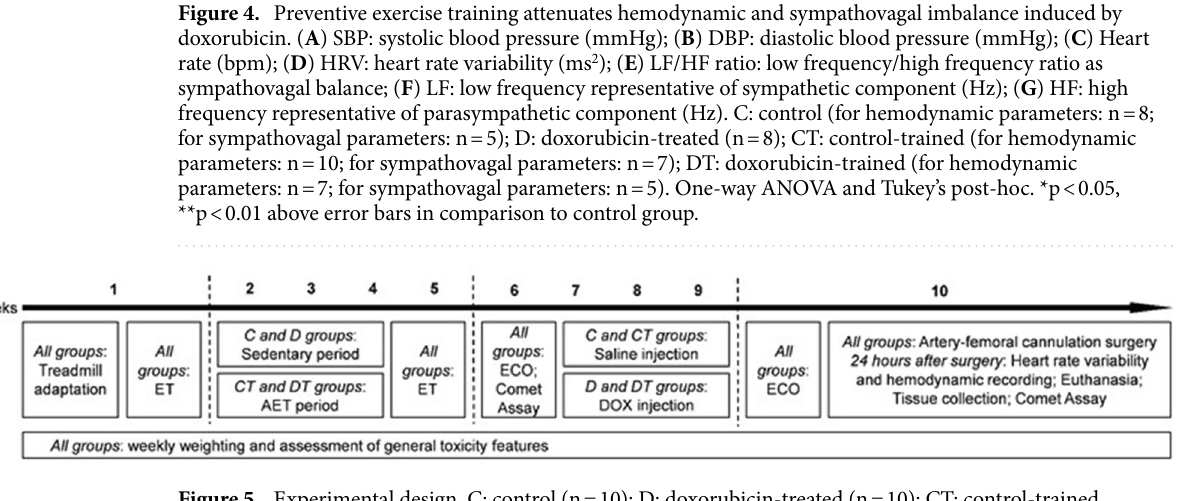
Figure 5. Experimental design. C: control (n = 10); D: doxorubicin-treated (n = 10); CT: control-trained (n = 10); DT: doxorubicin-trained (n = 10); AET: aerobic exercise training period; ECO: echocardiographic assessment; ET: maximal exercise